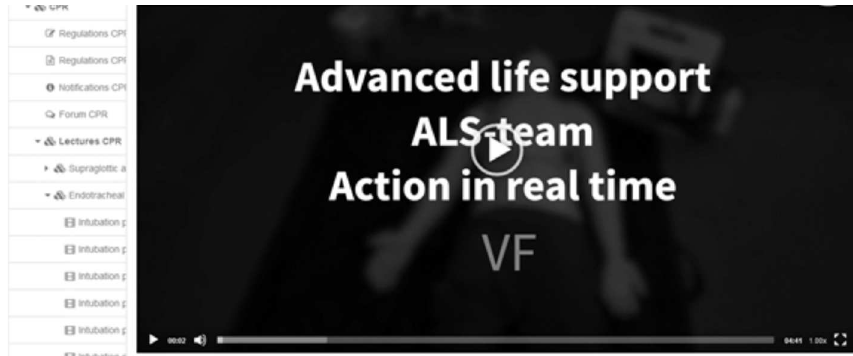
Figure 5. ALS movie in real time